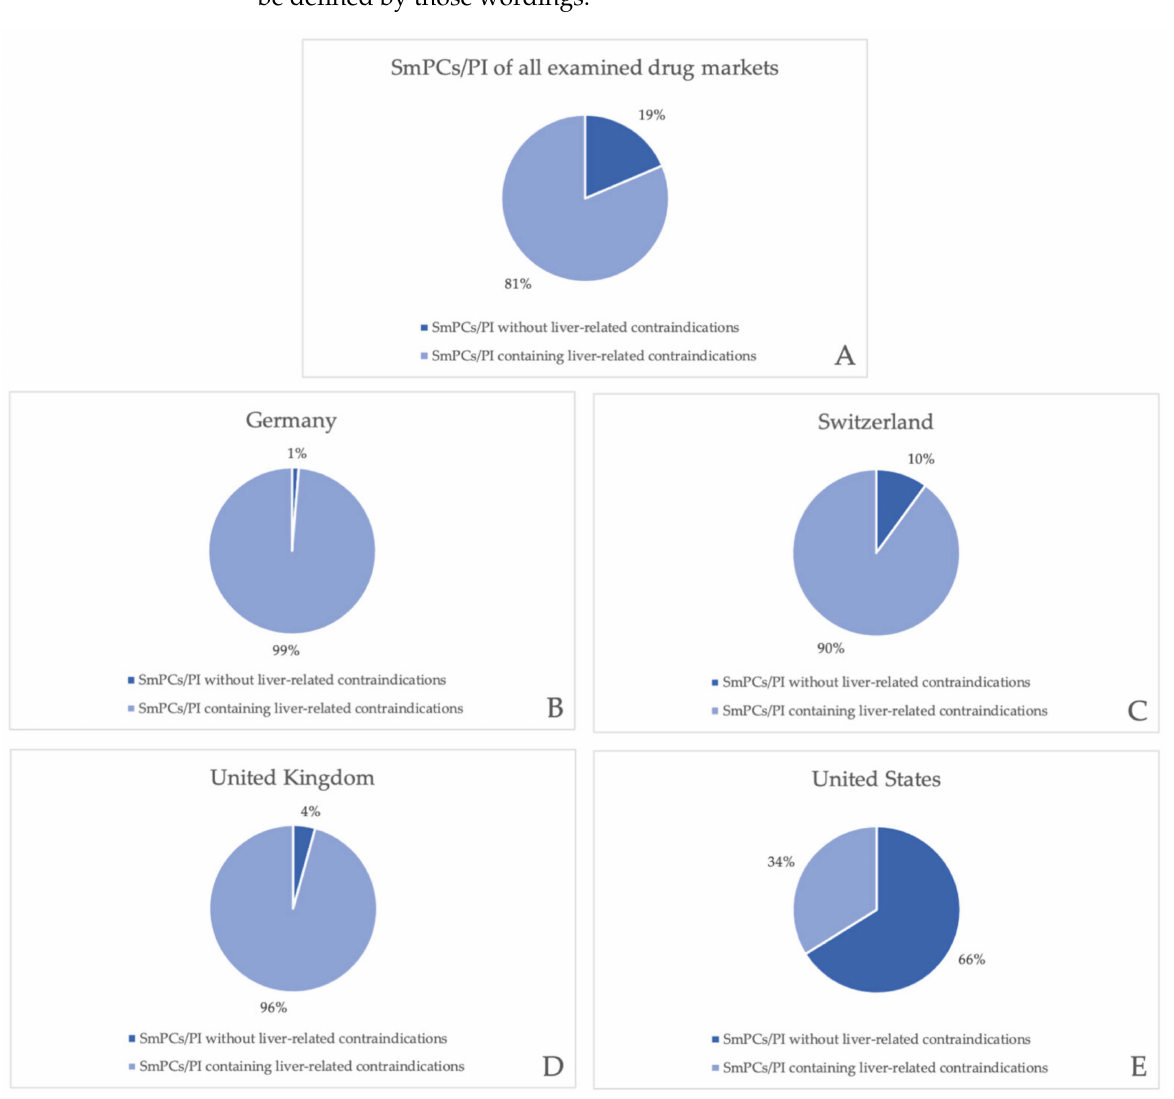
Figure 5. Portion of SmPCs/PI containing and without liver-related contraindications. ( A ) In the four chosen drug markets, ( B ) in Germany, ( C ) in Switzerland, ( D ) in the United Kingdom, and ( E ) in the United